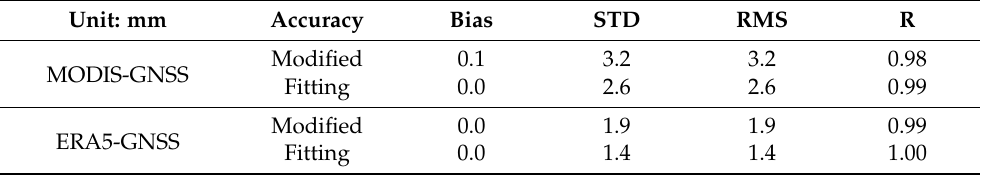
Figure 3. Scatter plots of the modified MODIS PWV against observed (GNSS) PWV. Table 3 presents the overall performance of the quarterly models with the optimal spread parameter given in Appendix B. The systematic difference between MODIS (ERA5) PWV and GNSS PWV is also eliminated after training since the bias is close to 0. The accuracy in terms of RMS of the quarterly model is improved by 2.5 mm for MODIS PWV and 1.1 mm for ERA5 PWV, which are better than the improvement achieved by the annual models. Table 3. Model performance based on quarterly